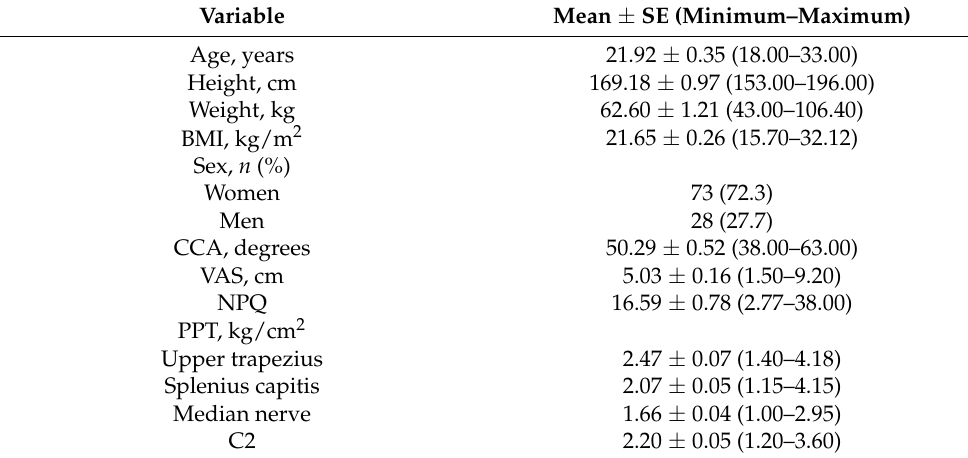
Figure 1. Flow diagram of subjects. Table 1. Characteristics of the subjects ( n =